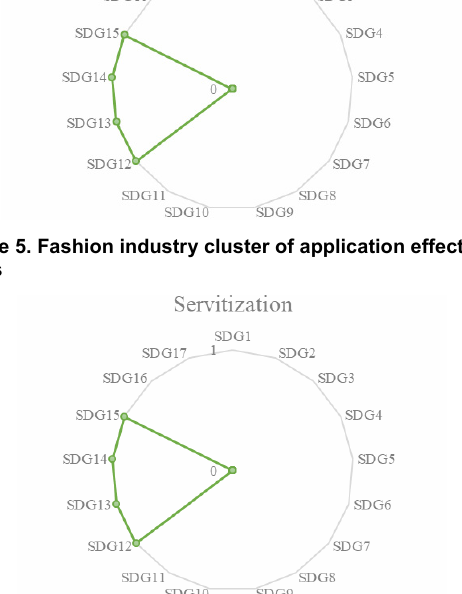
Figure 6. Servitization cluster of application effect on